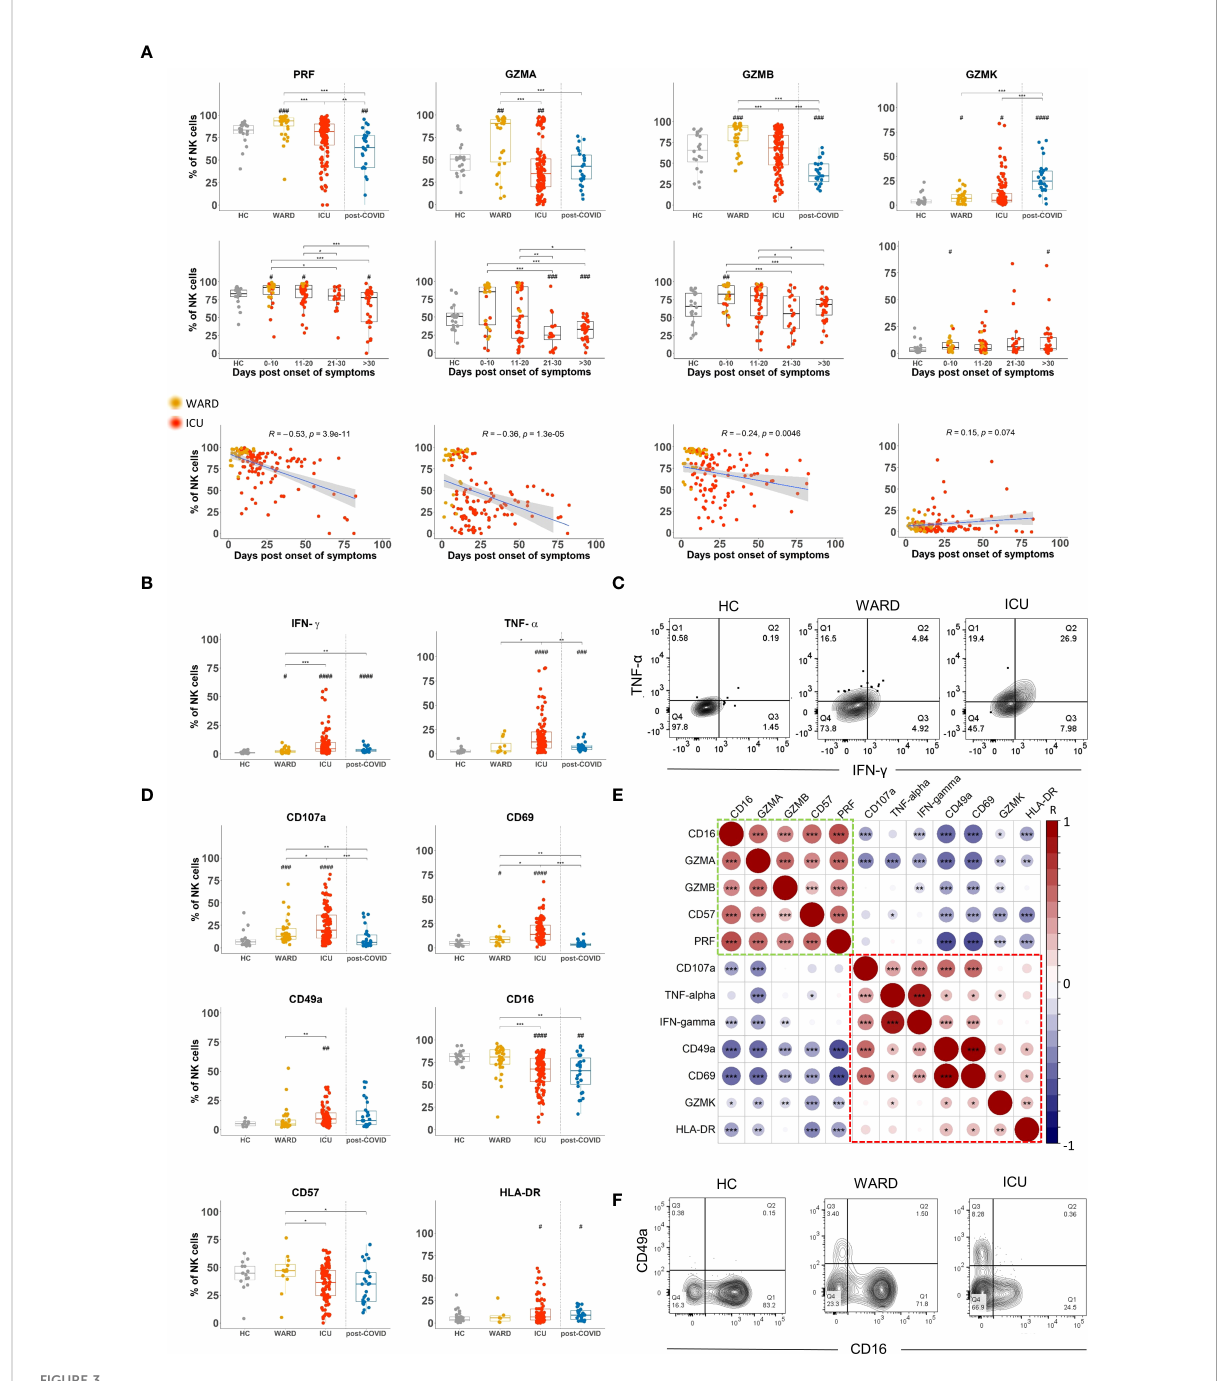
FIGURE 3 Shift in NK cell phenotype from a cytotoxic to a cytokine-producing pro fi le in WARD and ICU and during the course of COVID-19 disease (A) Percentage expression levels of cytotoxic molecules on total natural killer (NK) cells in healthy controls (HCs) (n = 18), WARD (n = 34), ICU (n = 61) and post-COVID-19 patients (n = 28), upon return to the hospital six weeks after discharge. WARD (yellow) and ICU (red) samples were further subdivided based on the days post onset of COVID-19 symptoms. Pearson correlation between days post-symptoms and the indicated cytotoxic molecules in COVID-19 patients (bottom line). R = correlation coef fi cient. (B) Percentage expression of IFN- g and TNF- a by total NK cells of indicated groups. (C) Contour plot showing IFN- g and TNF- a expression by NK cells in HCs, WARD, and ICU COVID-19 patients. (D) Percentage expression of CD107a, CD69, CD49a, CD16, CD57, and HLA-DR on total NK cells. (E) Pearson correlation matrix for the tested markers. (F) Contour plot showing CD16 and CD49a expression on NK cells of indicated experimental groups. Each symbol represents a single patient. For the comparison of groups, p -values were obtained using Wilcoxon signed-rank test with Bonferroni correction. * Represent differences between indicated groups, # represent differences with HCs. */ # p<0.05; **/ ## p<0.01; ***/ ### p<0.001; ####